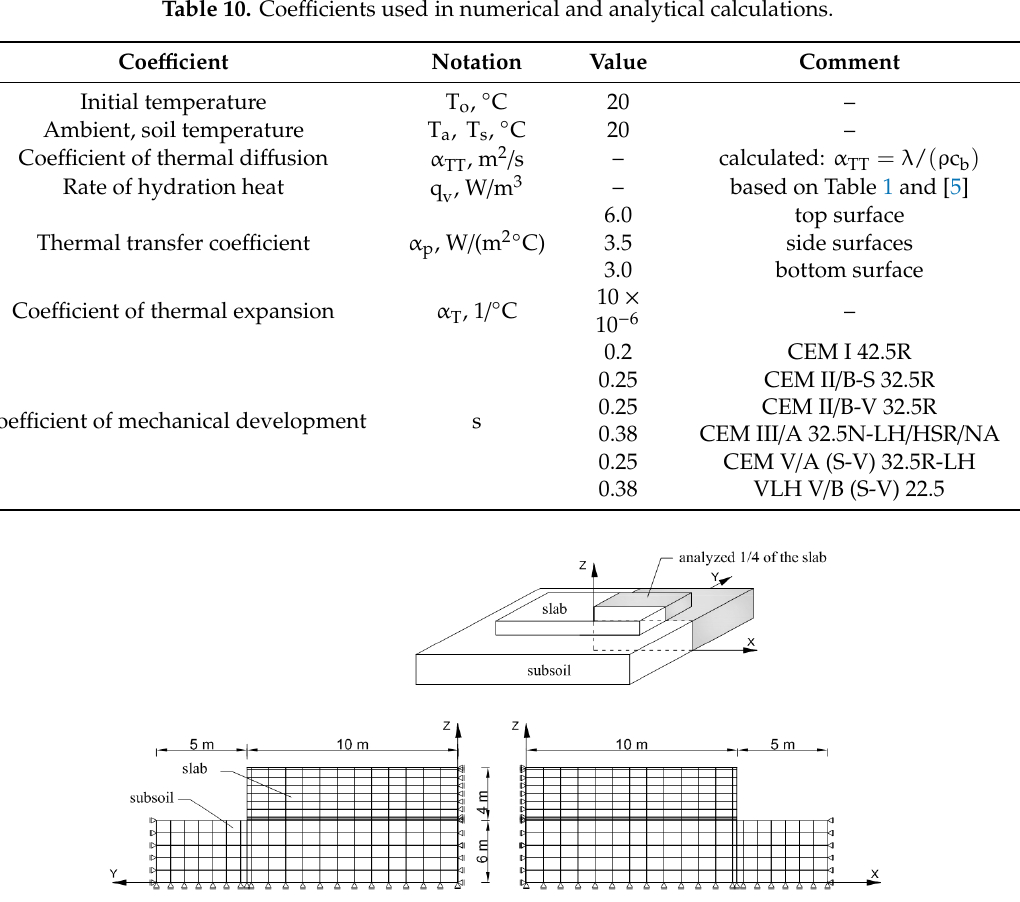
Table 10. Coefficients used in numerical and analytical calculations.